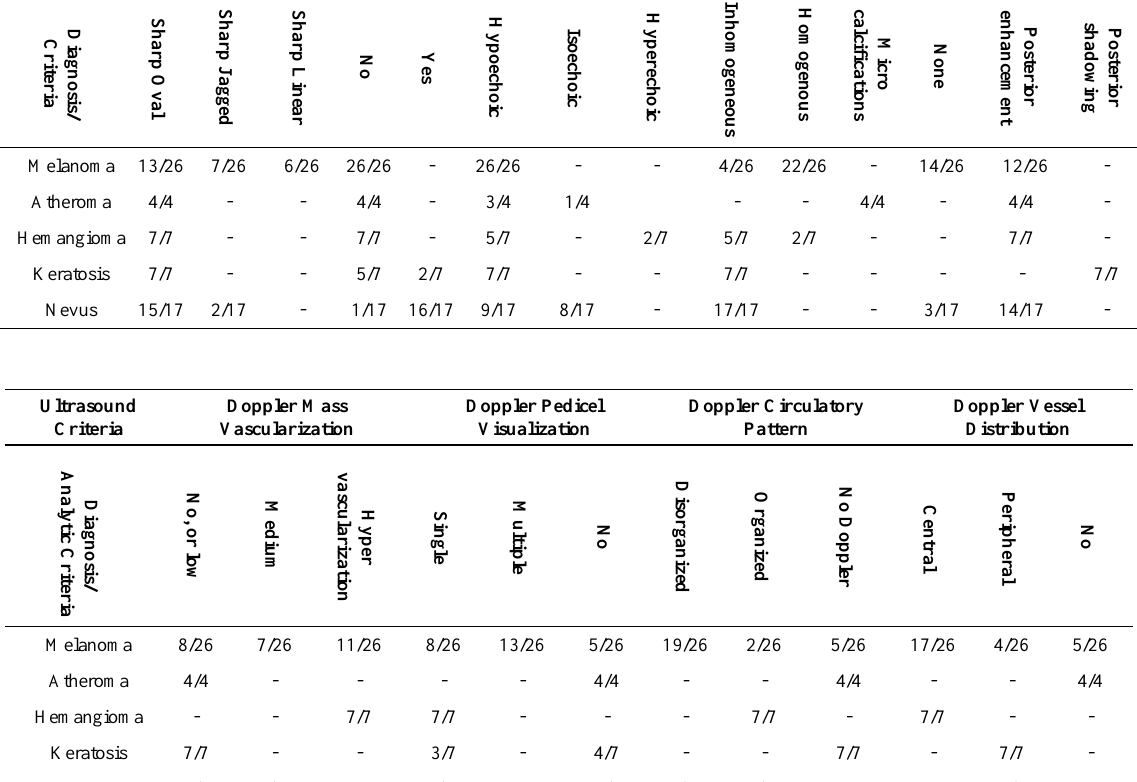
Table 1. Ultrasound analysis of malignant melanoma and skin benign pathologies (N of cases/N of Group) Ultrasound Circular Margins Echogenicity Criteria Rim